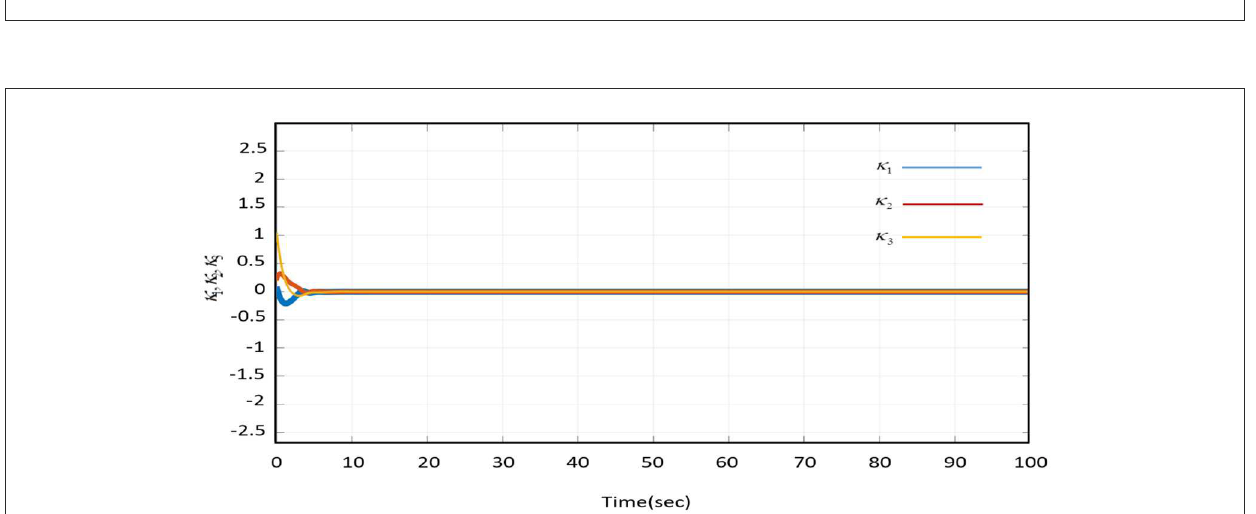
FIGURE11 The error model with the virtual variable for backstepping with activated